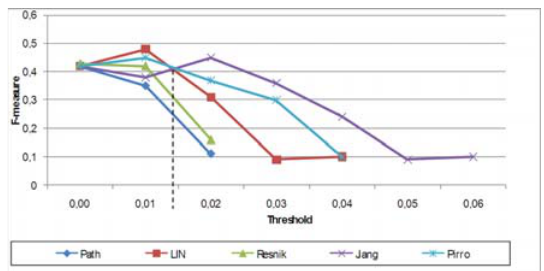
Fig. 2. The F-measure curves for the categorization process with different measures